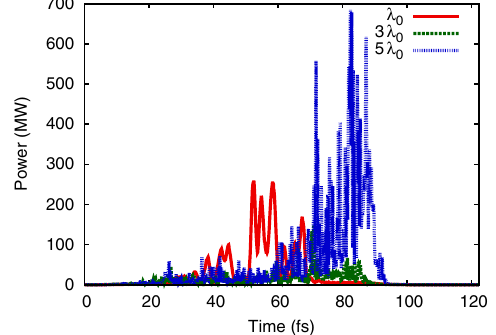
FIG. 20. Profile of the final output power produced at wave- lengths of 0.3 nm, 0.9 nm, and 1.5 nm for the start-to-end bunch.